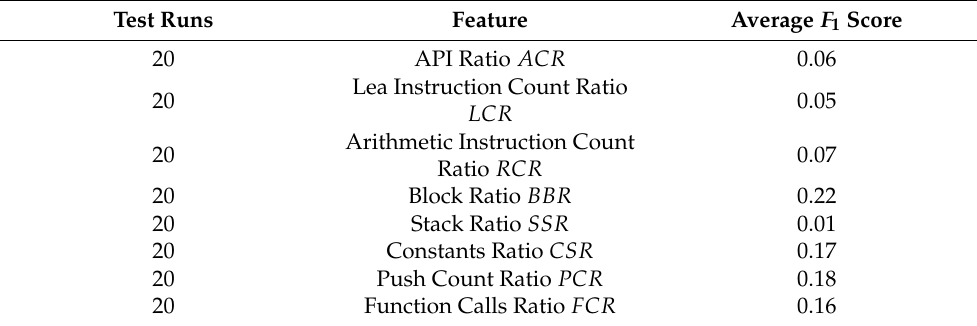
Table 3. Zeus/ISFB Individual Feature Performance.